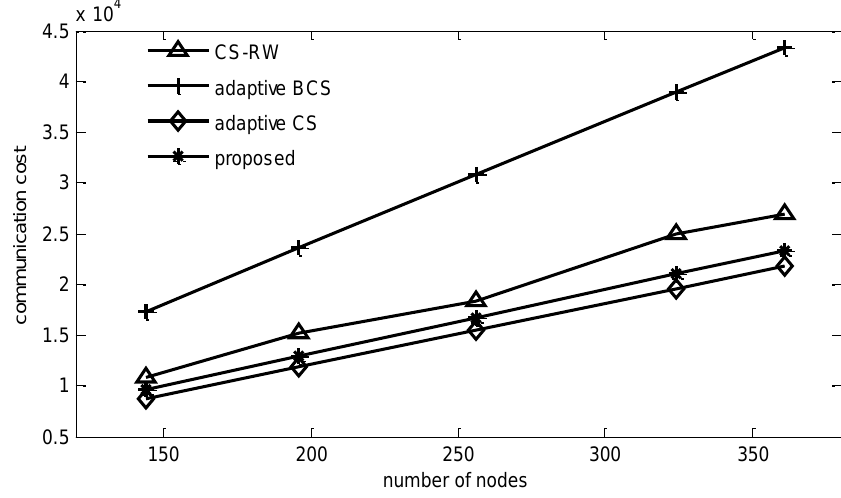
Figure 10. Communication cost vs. number of